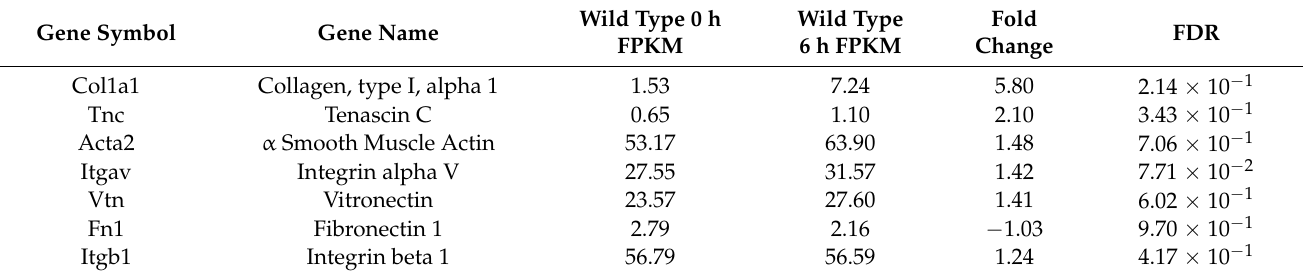
Table 2. The expression of classic fibrotic markers does not significantly change in mouse LECs by 6 h